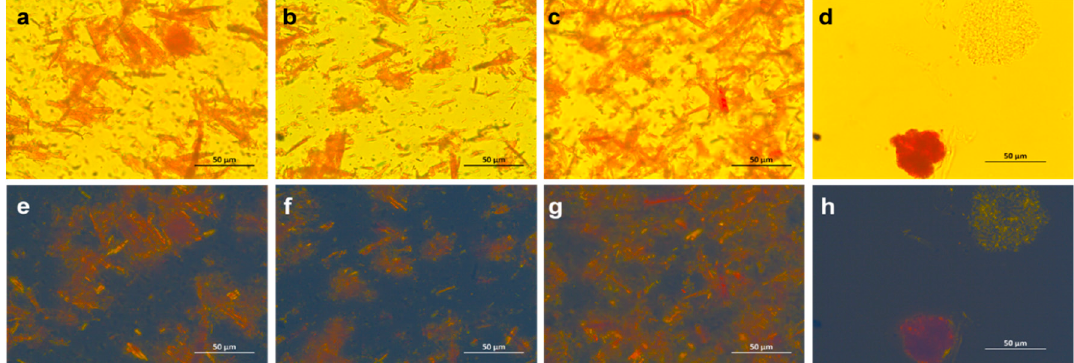
Figure 3. Micrographs of formulations. ( a – d ) formulations used in Groups 1, 2, 3 and 4, respectively, analysed by light microscopy, and ( e – h ) formulations used in Groups 1, 2, 3 and 4, respectively, analysed by polarised light